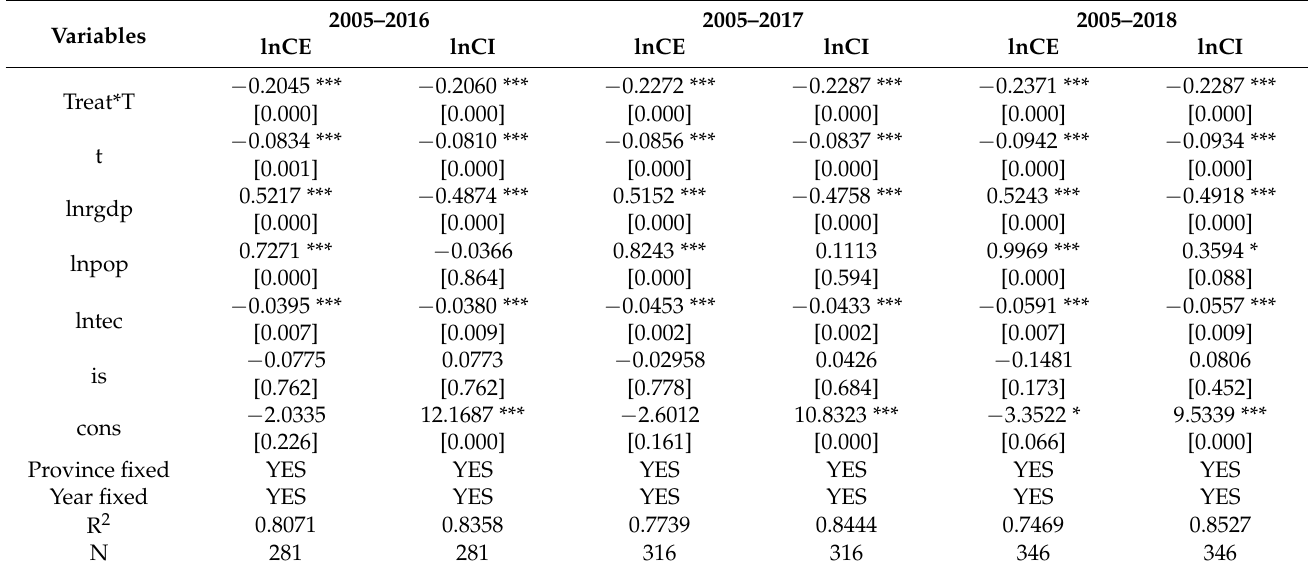
Table 8. Robustness test with different time widths.